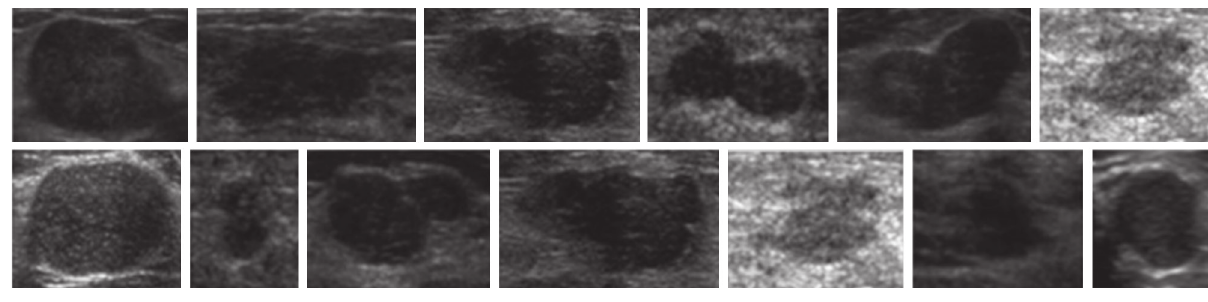
Benign US Breast Lesion